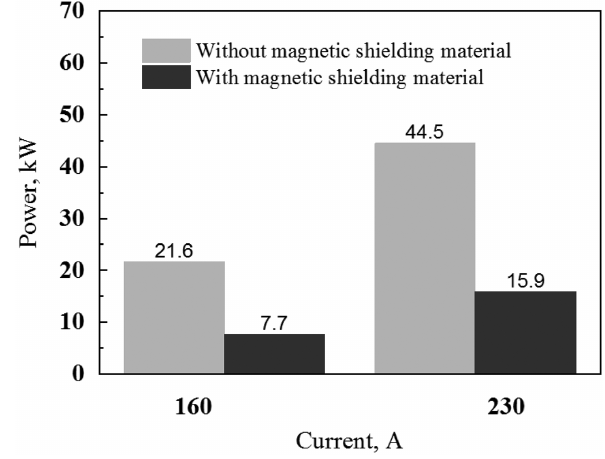
Figure 5: Power loss in different currents with or without the mag- netic shielding